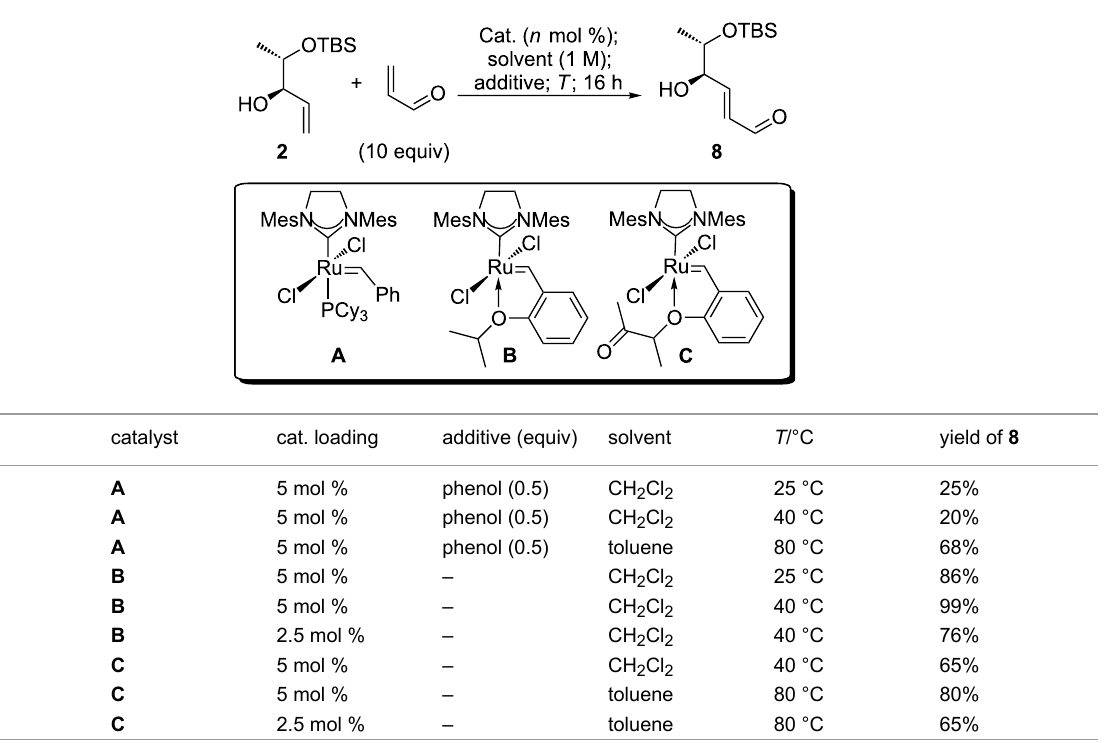
Table 1: Catalyst screening for CM of allyl alcohol 2 and acrolein.